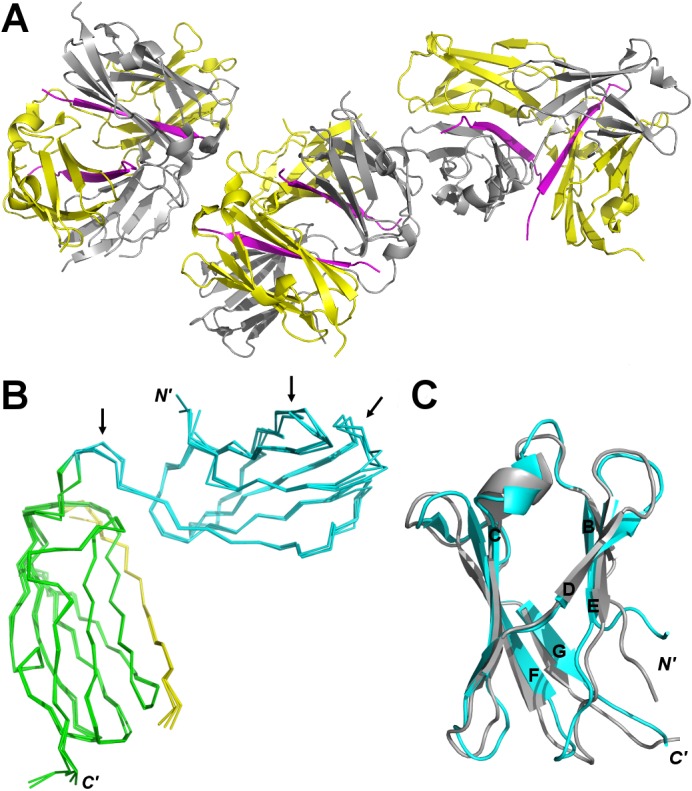
Crystal structure of IgFLNa∆A20–21-migflin peptide complex.
A The asymmetric unit. FLN chains are colored in yellow and grey, and migfilin chains in magenta. B All six IgFLNa∆A20–21 chains of the asymmetric unit superimposed. All chains are nearly identical with each other. The greatest variation is seen in the inter-domain loop and at the loop regions of IgFLNa20 (shown with the black arrows). IgFLNa20 is colored in cyan, IgFLNa21 in green, and migfilin peptide in yellow. C Superimposition of IgFLNa20 (in cyan) from the crystal structure reported here and IgFLNb20 NMR structure (in gray) (2DLG). The structures are similar with CD faces adopting a closed conformation.